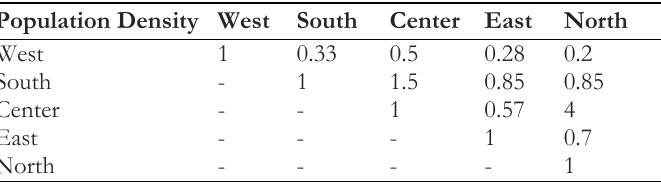
Table 4. Matrixes of pairwise comparisons of regions based on: a. population density; b. region